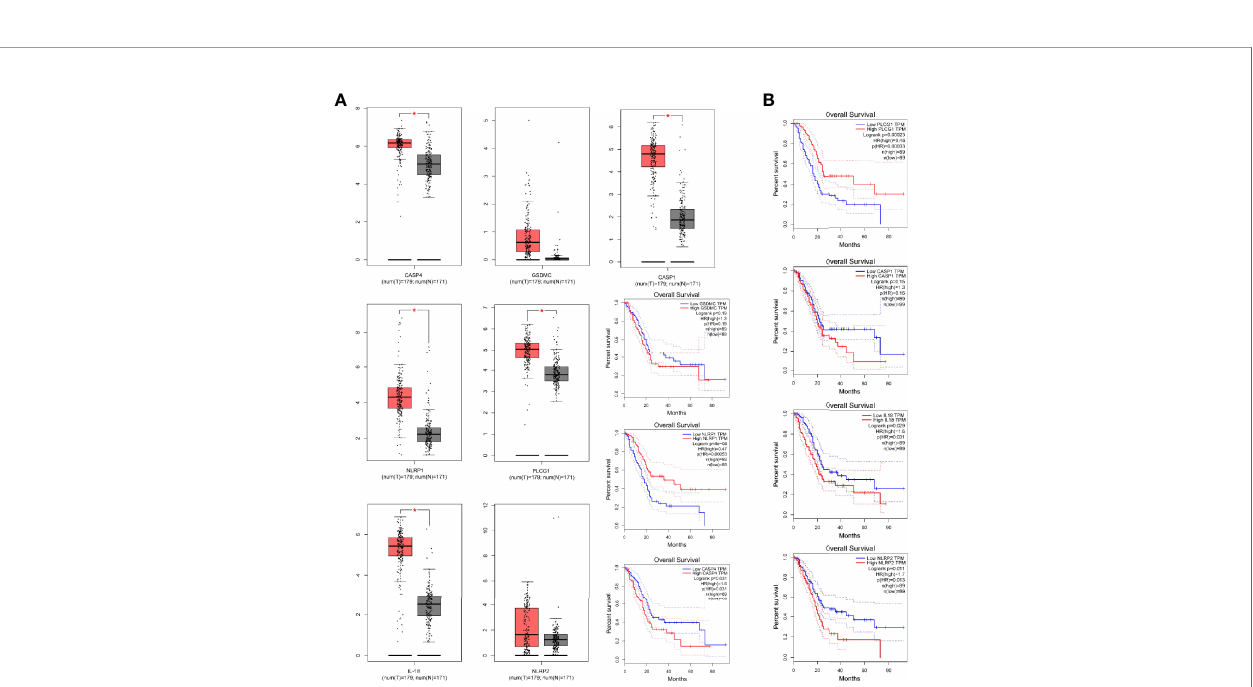
FIGURE 9 | The Differential expression of pyroptosis-related genes in prognostic model. (A) The expression of CASP4, NLRP1, PLCG1, GSDMC, IL-18, NLRP2 and CASP1 by GEPIA. (B) Kaplan-Meier survival analysis for above PRGs. *p <